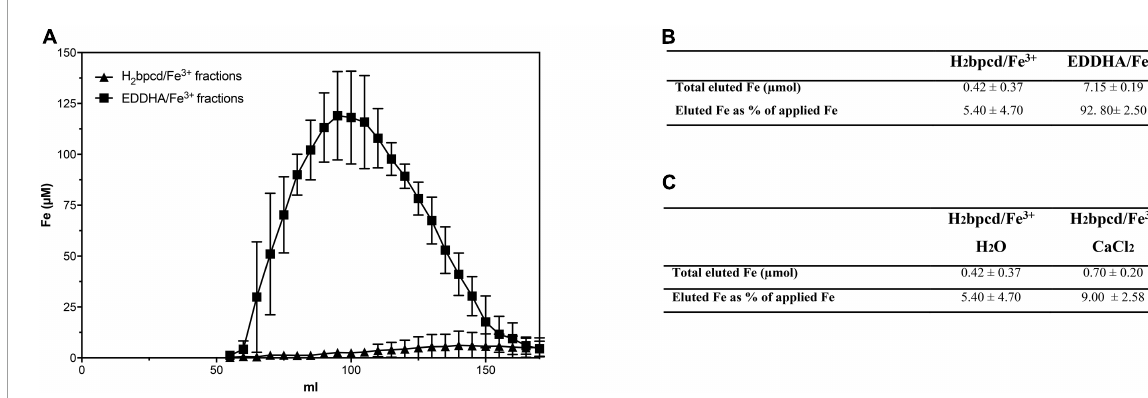
FIGURE5 Leaching through the soil columns: (A) profile of eluted Fe after the application of H 2 bpcd/Fe 3 + and EDDHA/Fe 3 + and (B) comparison of the total amount of eluted Fe after the application of both Fe sources when elution was carried out with H 2 O, and (C) comparison of the total amount of eluted Fe after the application H 2 bpcd/Fe 3 + between elution with H 2 O and 0.5 M CaCl 2 . Data are expressed as mean ± S.D. of three independent replicates.